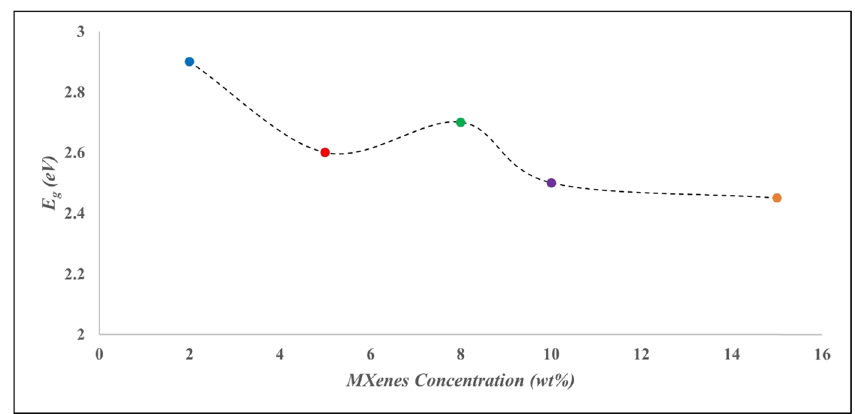
Figure 10: The Tauc plot illustrates the band gap ( E g ) variation in nanocomposites as a function of MXenes